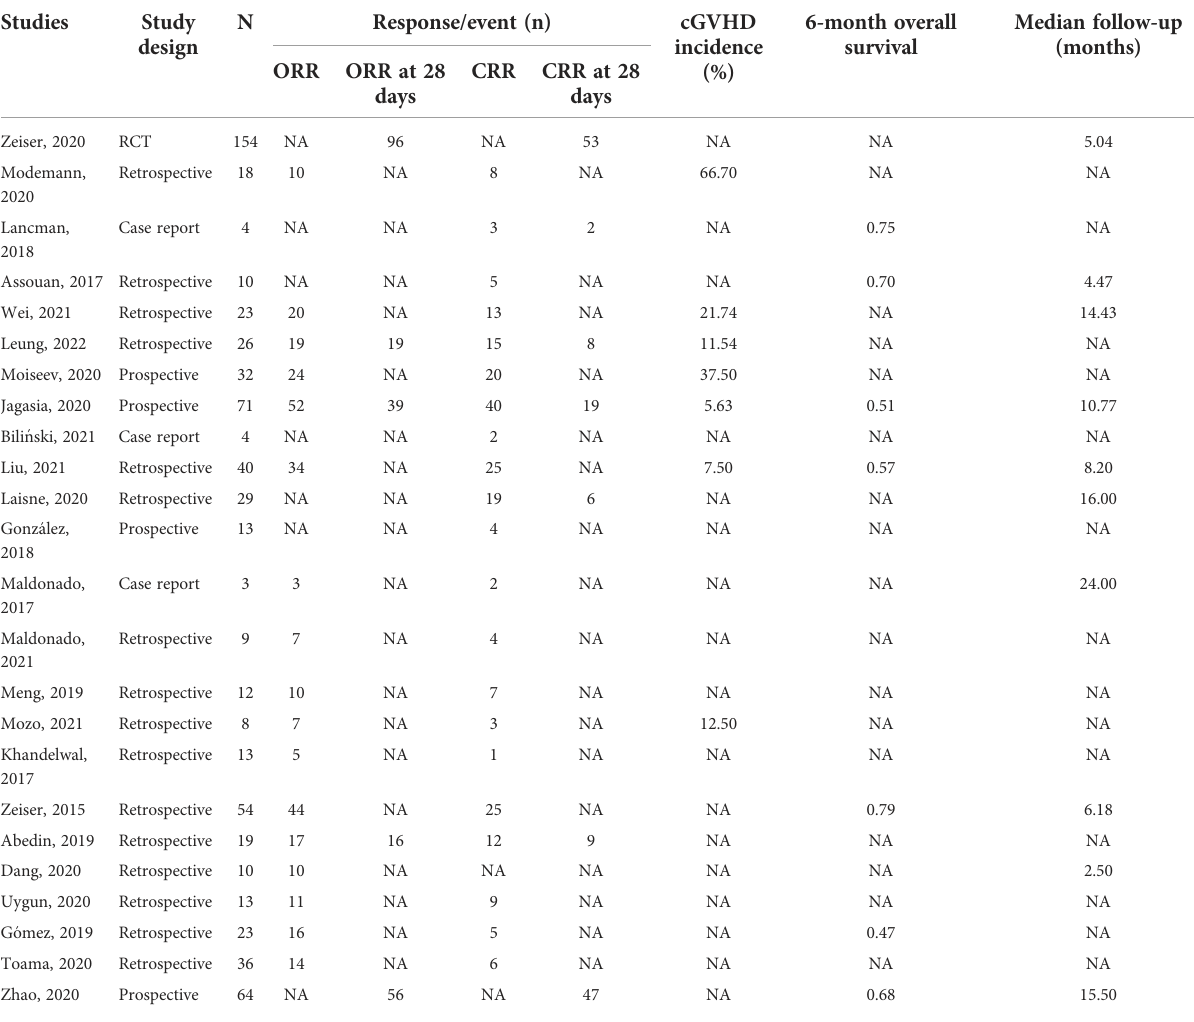
TABLE 3 Characteristics of therapeutic response for 24 included studies (SR-aGVHD) * .